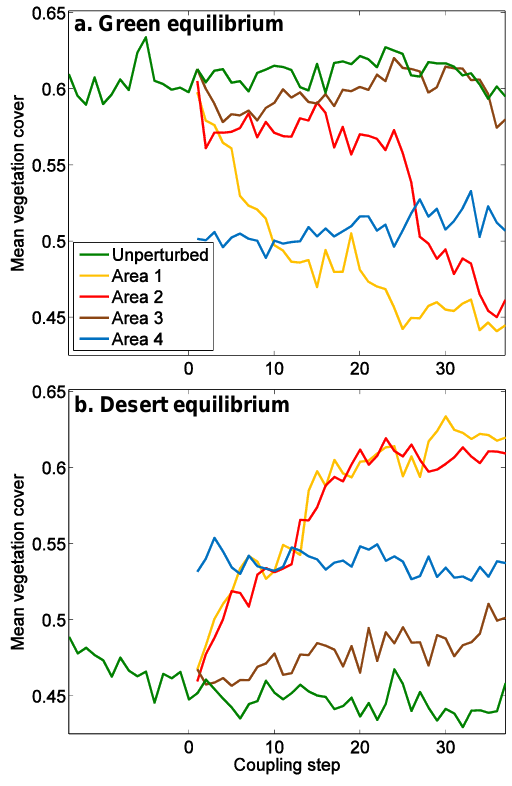
Fig. 9. Evolution of vegetation cover fraction in PlaSim-VECODE- eq with perturbations in different areas. All vegetation cover frac- tions are averaged over the complete region shown in Figs. 10 and 6 (5 ◦ N–50 ◦ N, 14.6 ◦ W–76.5 ◦ E). The colours correspond to the ar- eas marked in Fig. 6, where vegetation cover is set to 0 (a) or 1 (b)